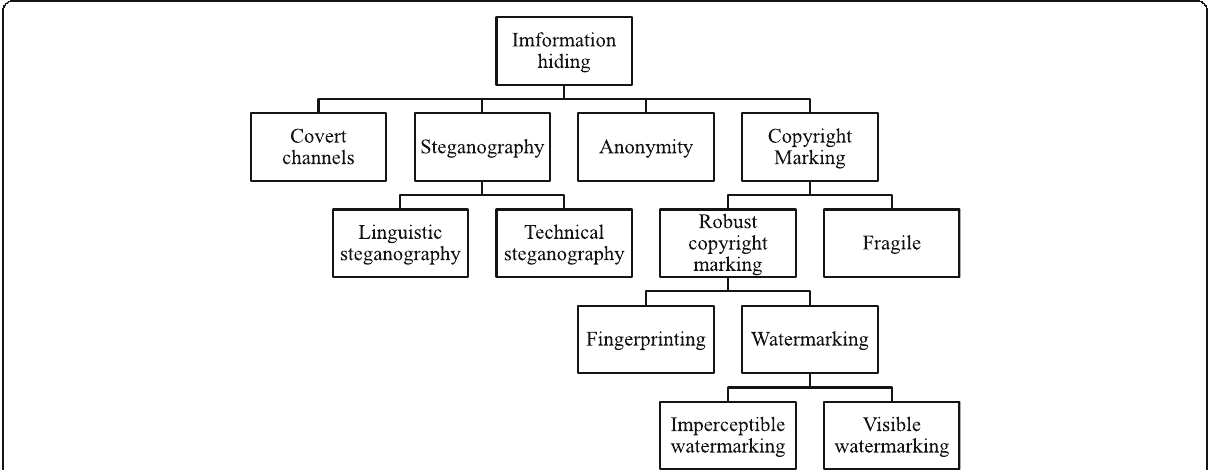
Fig. 1 Classification of information hiding technologies. The four types of information hiding technologies are covert channels, steganography,